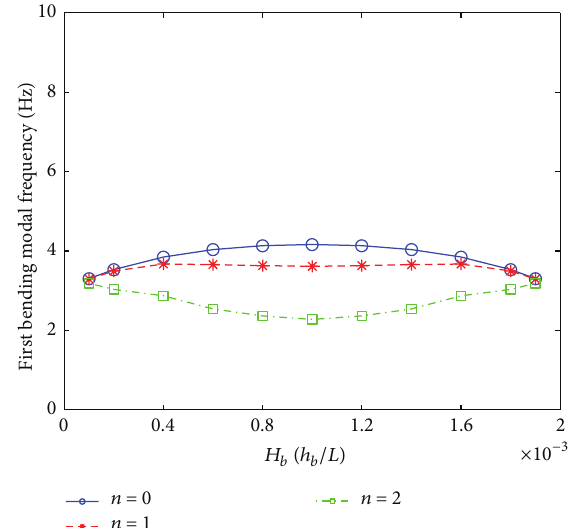
Figure 18: Natural frequency results for different CLD configura- tions ( 𝐻 𝑏 + 𝐻 𝑐 = 0.002